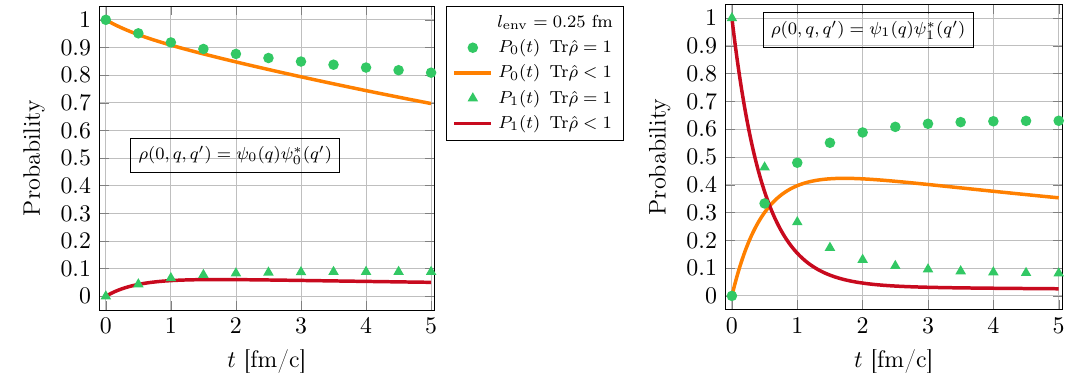
Figure 4 . Probabilities P 0 ( t ) ; P 1 ( t ) of having respectively the ground state 0 and the excited state 1 at time t , starting o(cid:11) with an initial density matrix (cid:26) 0 ( q; q 0 ) = (cid:26) (0 ; q; q 0 ) corresponding to the ground state (on the left) or excited state (on the right). The physical case corresponds to the discrete data points, obtained by solving the Lindblad equation (6.6), which preserves the trace of the density operator. The continuous lines represent the probabilities computed using the ansatz (7.1), which does not preserve